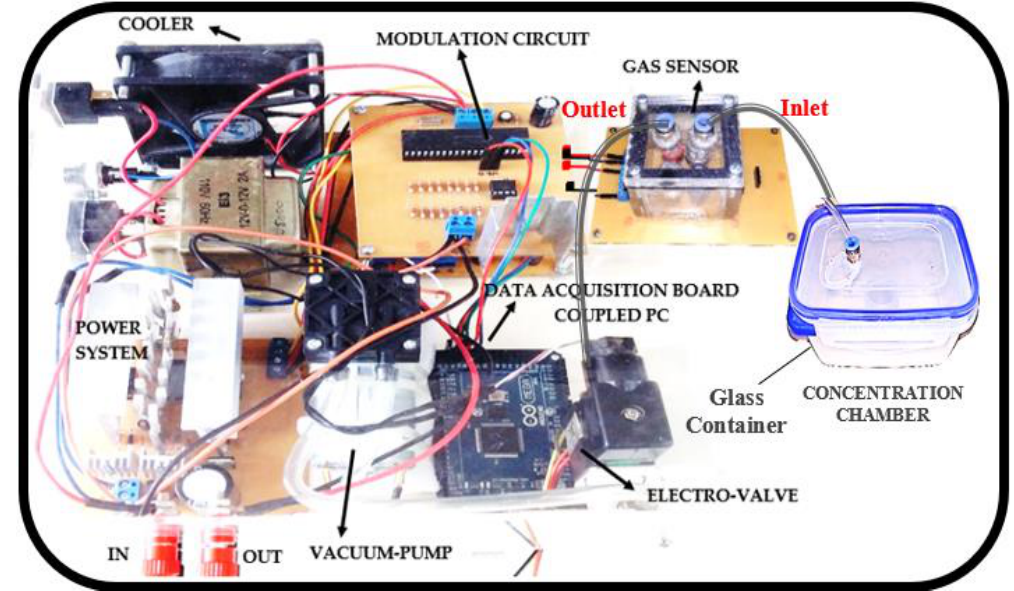
Figure 4. Experimental setup (homemade).